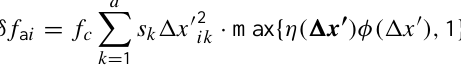
Fig. 2. Behaviour of four different upper bounds for the approx- imation error. These four models adopt a quadratic behaviour for ∆ x 0 < 1 , but differ in the way in which they estimate the higher- order terms in the Taylor approximation for larger ∆ x 0 .